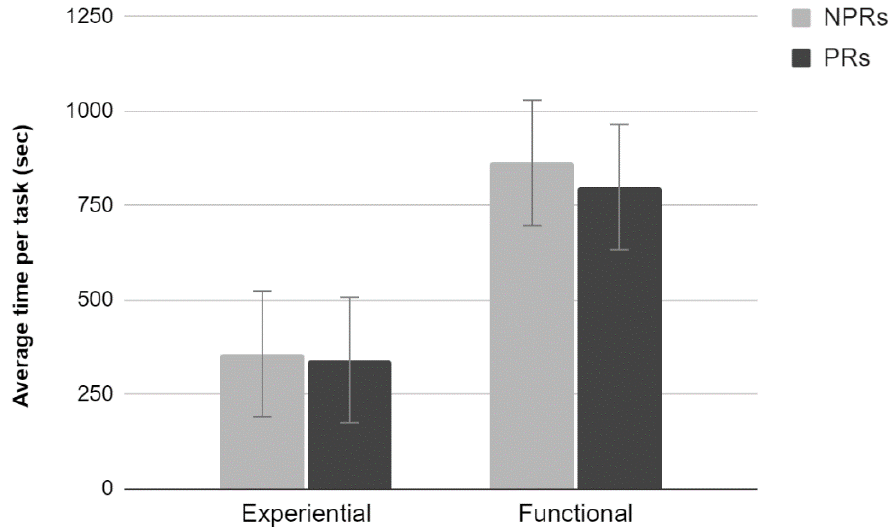
Figure 11. Average time per task by Experience (NPRs vs. PRs) and Test (Experiential vs. Functional). Error bars denote 0.95 confidence intervals.